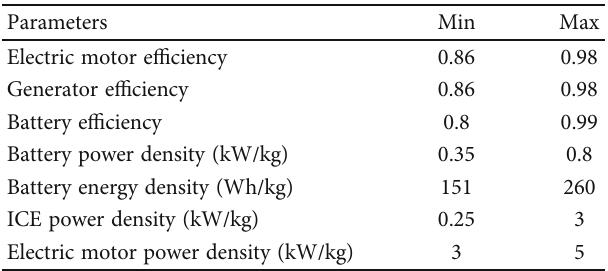
Figure 1: Con fi guration of fi xed wing VTOL aircraft and series system. (a) Fixed wing VTOL aircraft. (b) Series system. Table 1: Technology assessment of hybrid-electric systems